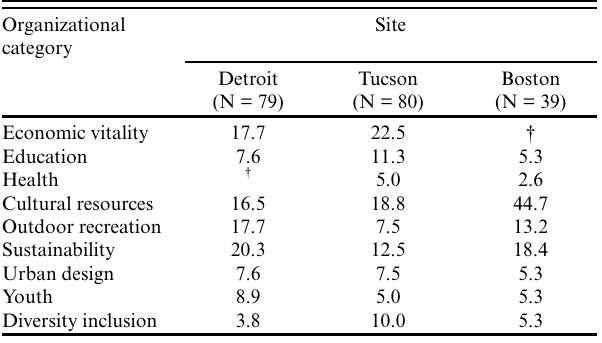
Table 3 . National Park Service Urban Agenda organizational categories by percent (%) of collaborative network list for each site.